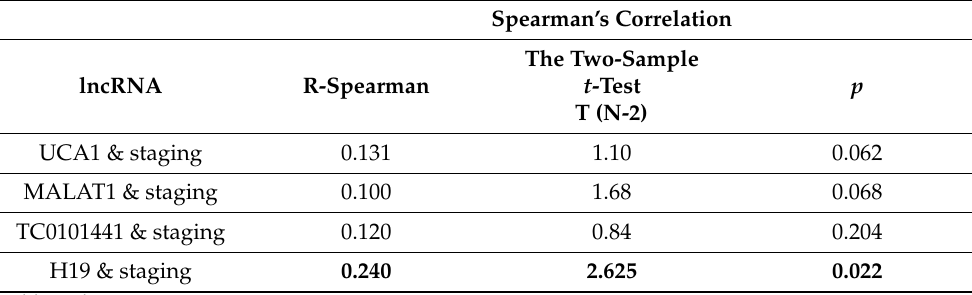
Table 3. Correlation between lncRNA and the clinical staging of the patients with endometriosis ( n = 100) by the rASRM classification.